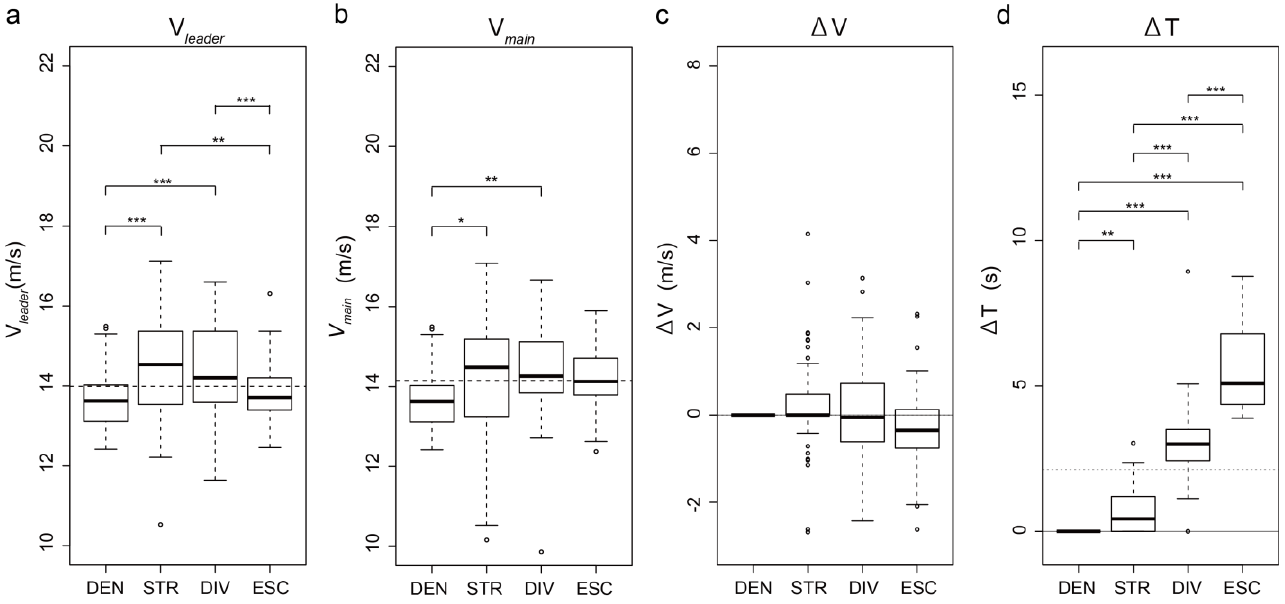
Figure 1. Candidate descriptive parameters for four global states: DEN, STR, DIV, and ESC. The box plots show the comparison of distributions in each parameter: V leader ( a ), V main ( b ), ΔV ( c ), and ΔT ( d ) in each state, respectively.